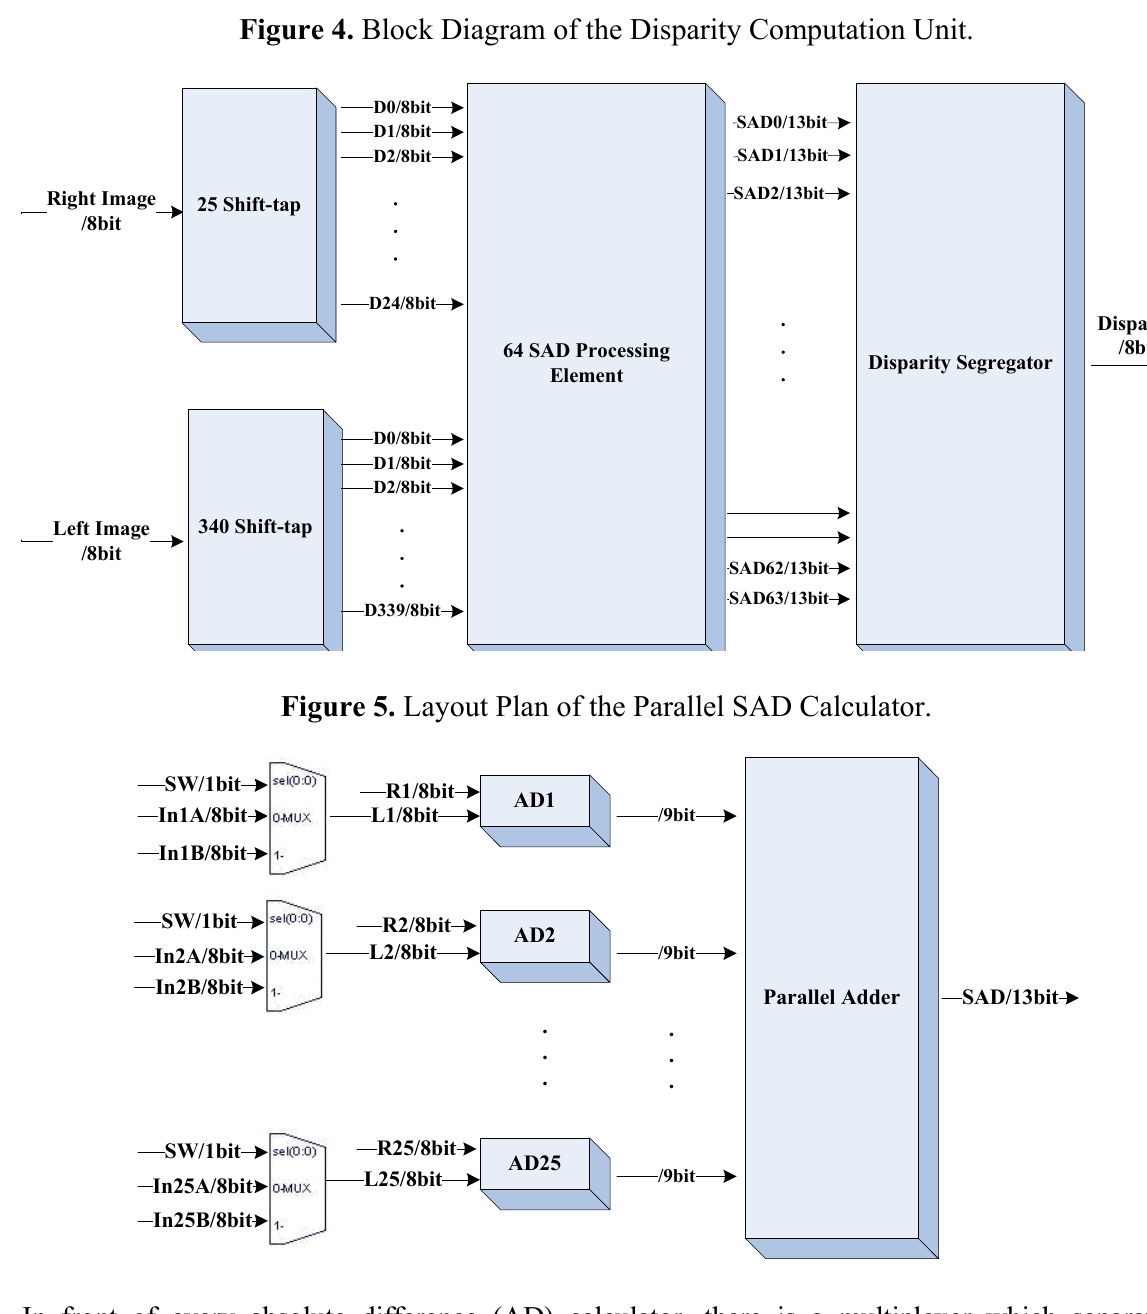
Figure 4. Block Diagram of the Disparity Computation Unit.